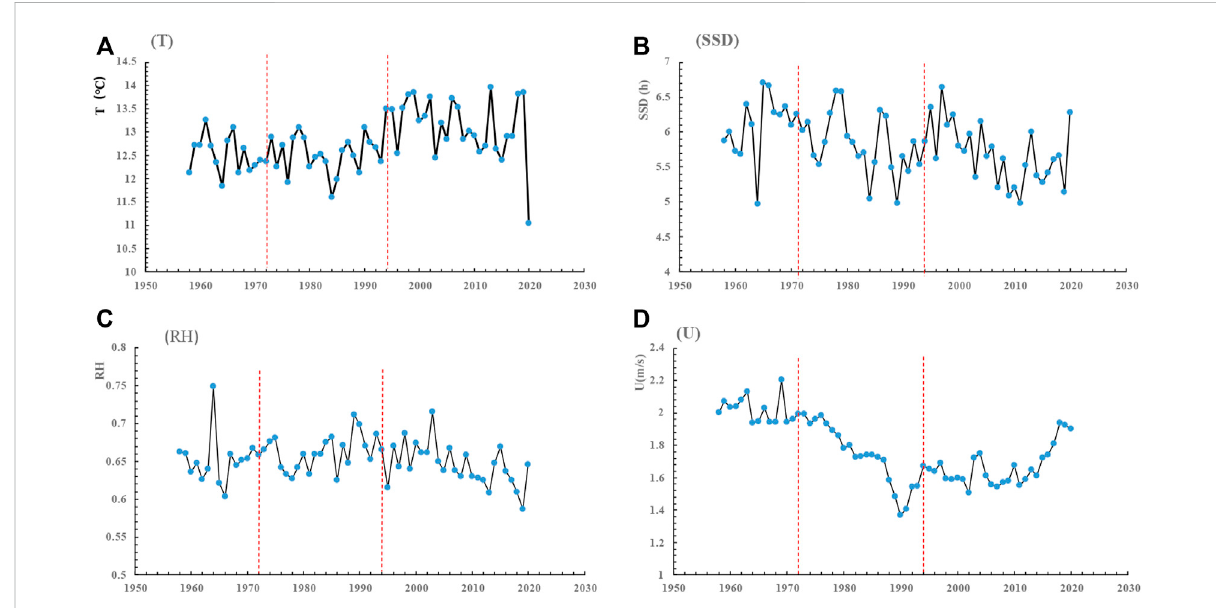
FIGURE 6 Variation trends of the meteorological factors: (A) the variation trend of T; (B) the variation trend of SSD; (C) the variation trend of RH; (D) the variation trend of